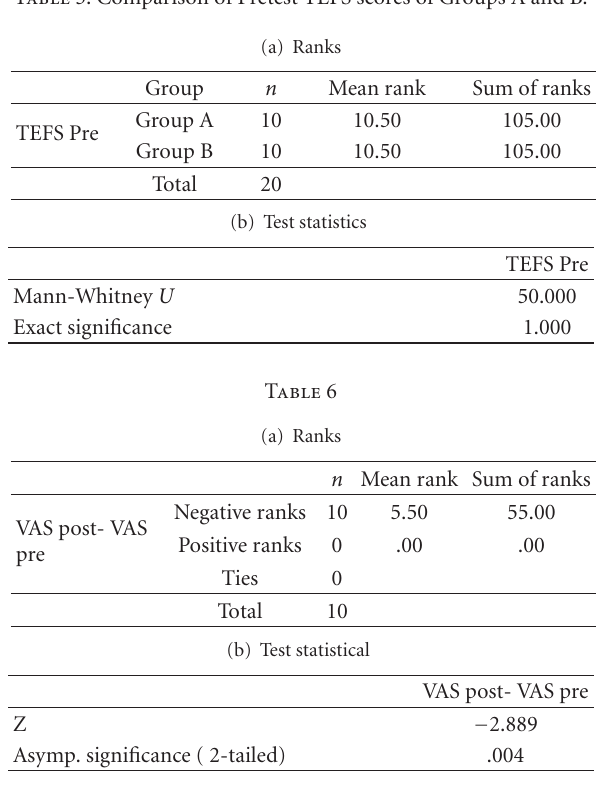
Table 5: Comparison of Pretest TEFS scores of Groups A and